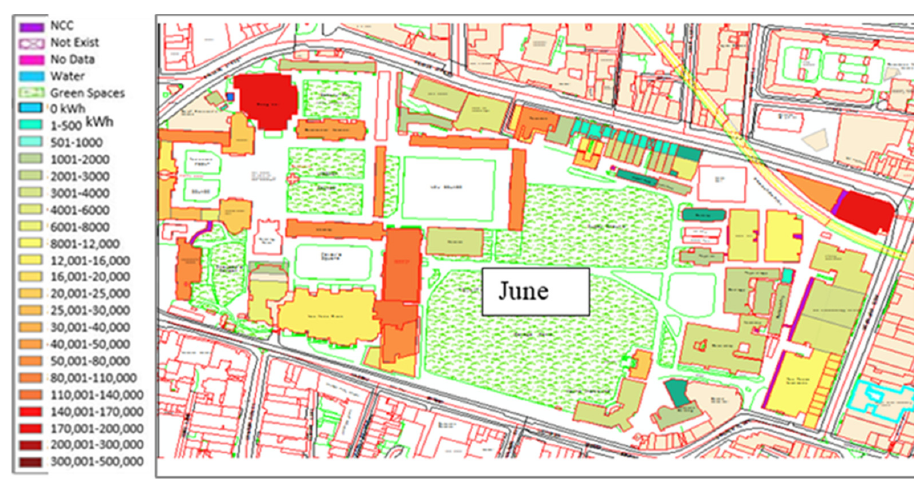
Figure 10. Heat demand map of June.